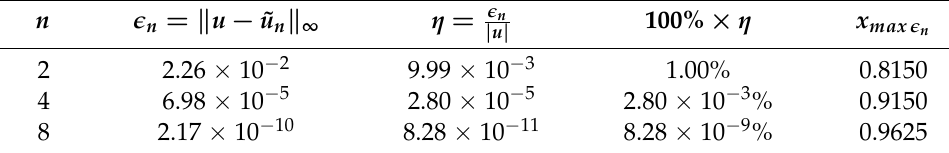
Table 4. IE (48), λ A = 2. DKM: Polynomials.